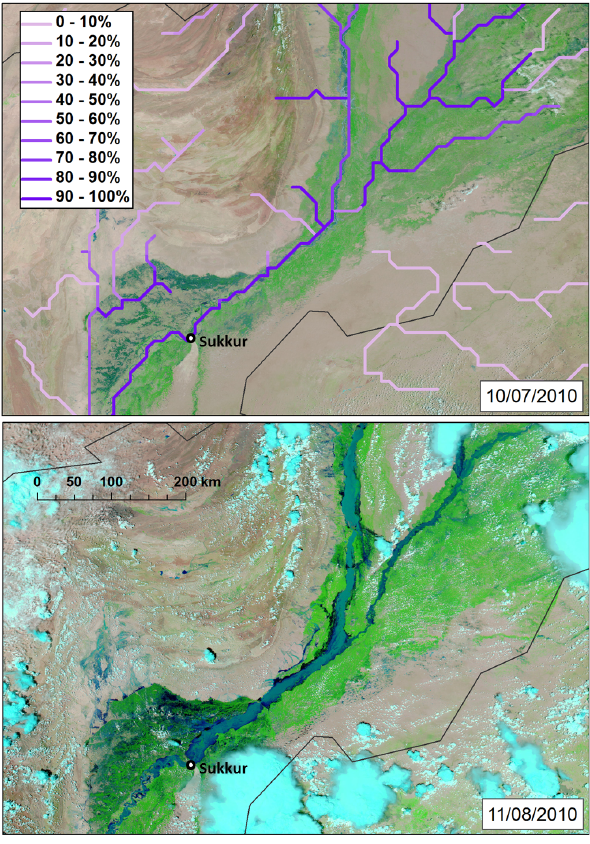
Fig. 12. Satellite images of the Indus River on 10 July 2010 (top) and on 11 August 2010 (bottom). Top panel also shows, with purple shadings, the maximum probability of exceeding the severe thresh- old in a 20-day forecast range (forecast on 28 July